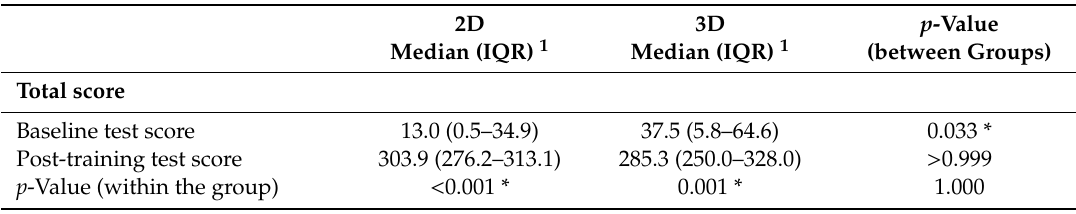
Table 2. Comparison of the baseline and post-training test scores for the total scores as well as for the four di ff erent Fundamentals of Laparoscopic Surgery tasks (peg transfer, pattern cutting, suturing with extracorporeal knot tying, and suturing with intracorporeal knot tying) within and between groups using the respective assigned visualization